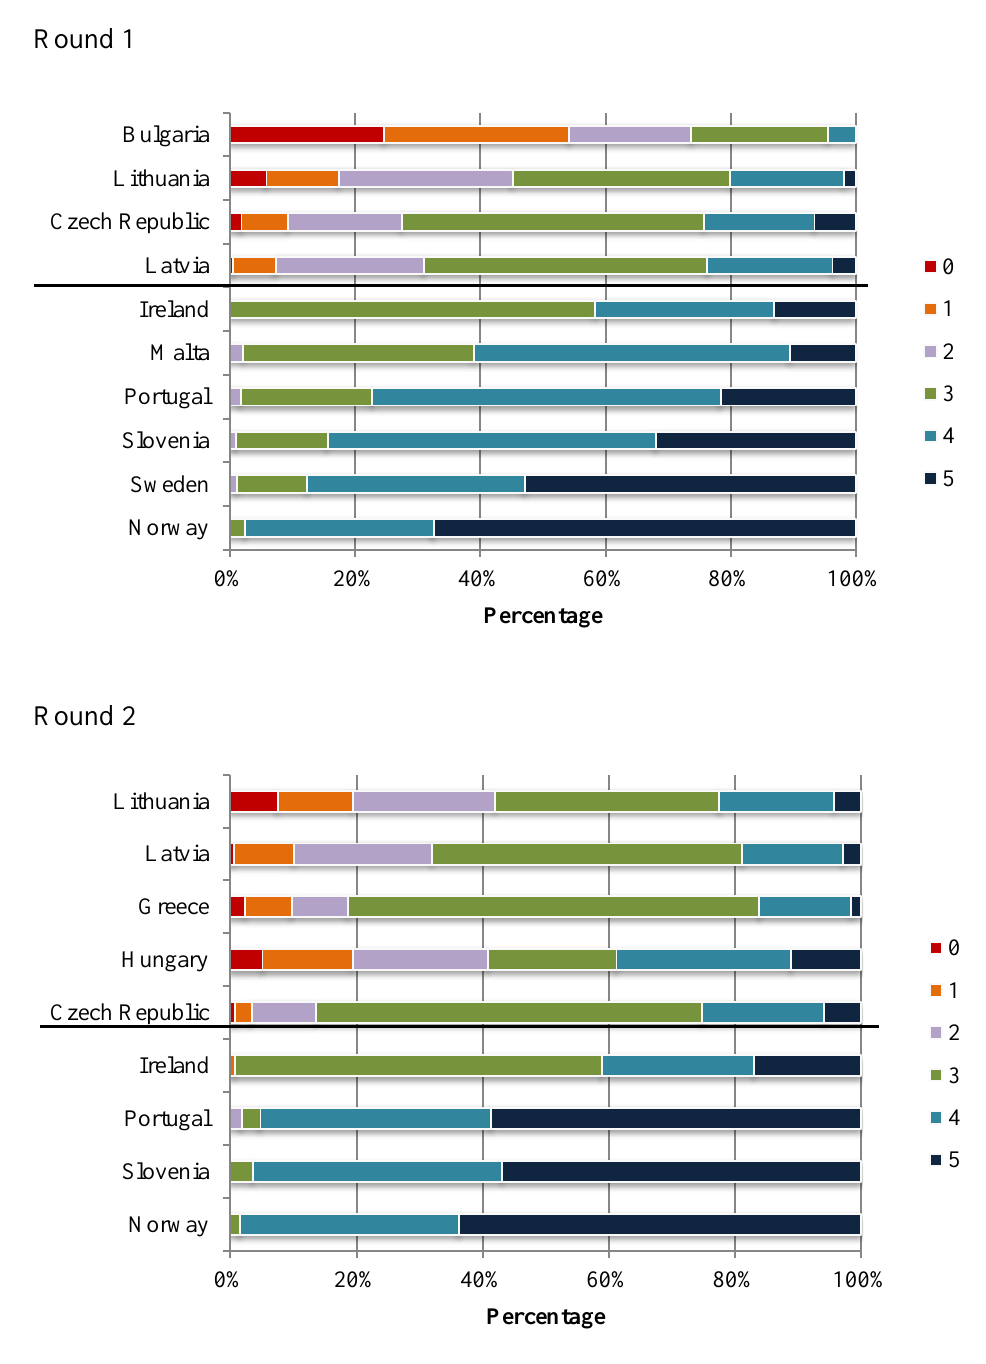
Figure 1. Distribution of schools in categories based on the number of characteristics graded as supportive (“five selected characteristics”) * in COSI rounds 1 (2007/2008) and 2 (2009/2010), by country (%) †